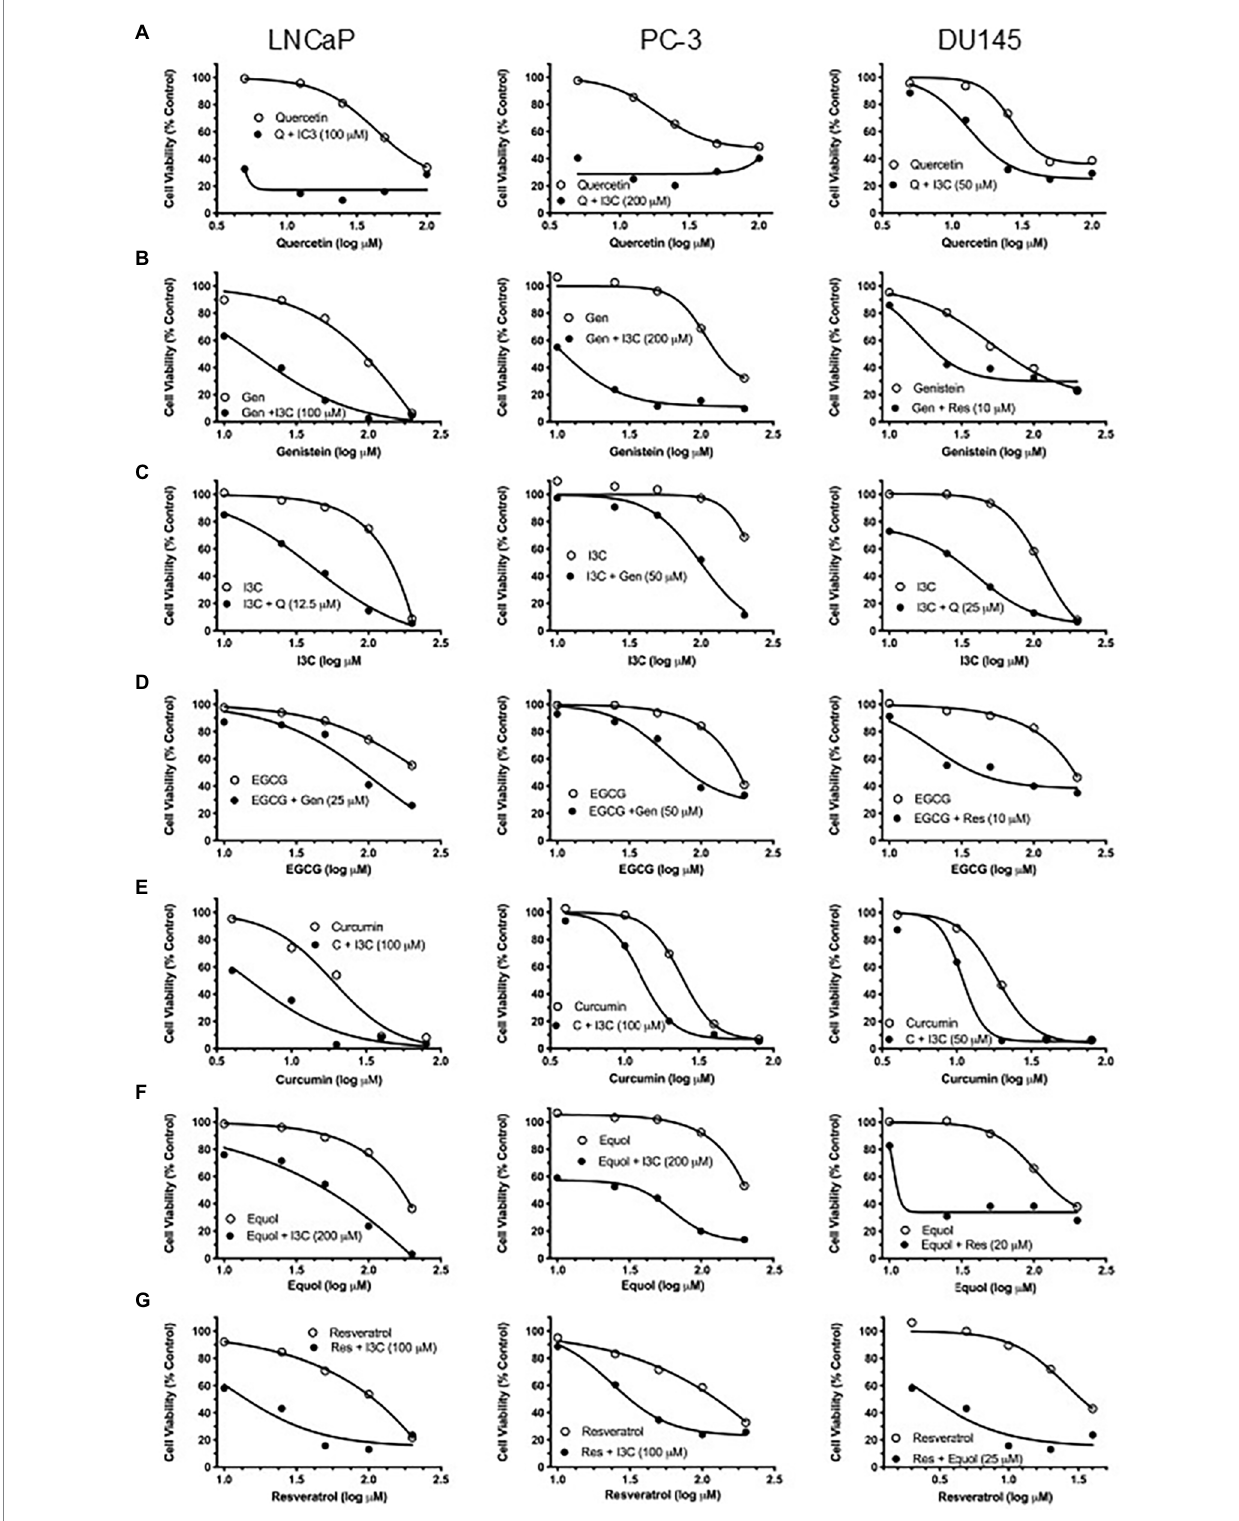
FIGURE 2 Effect of maximally synergistic combination on PC potency in each cell line. Cell viability of single-agent phytochemical (open symbols) and maximally synergistic dual combination (closed circles) for each phytochemical in each cell line. Identity and concentration ( μ M) of com-bination phytochemical is labelled in each graph. (A) Quercetin, (B) genistein, (C) I3C, (D) EGCG, (E) curcumin, (F) equol, (G)